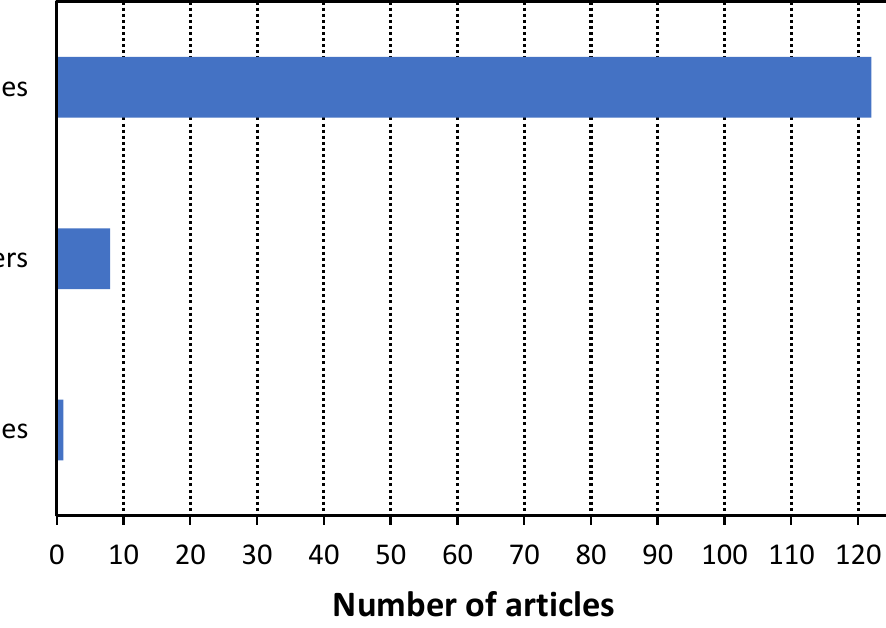
Figure 9. Histogram of the scientific articles about the three biorecognition technologies.